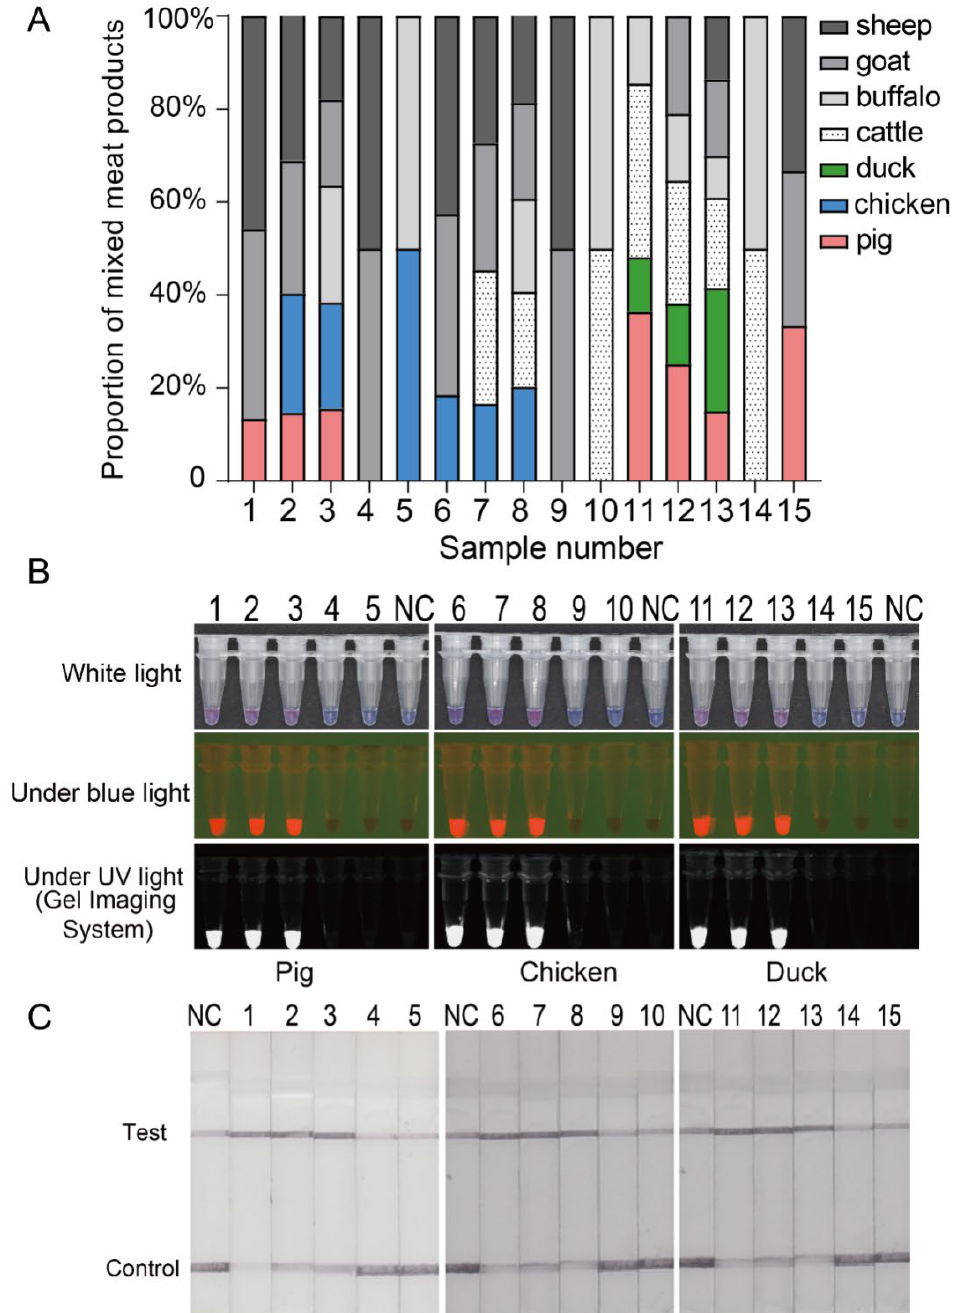
Figure 4. Detection of pork, chicken, and duck in simulated mixed meats based on naked-eyed colorimetric CRISPR/Cas12a assay. ( A ) Proportion of animal-derived components in simulated mixed meat samples. ( B ) Identification of pork, chicken and duck in simulated mixed meats based on naked-eyed colorimetric CRISPR/Cas12a assay. ( C ) Identification of pork, chicken and duck in simulated mixed meats based on CRISPR/Cas12a assay combined with a lateral-flow paper strip. 1–15 represents simulated mixed-meat samples. NC stands for negative control.